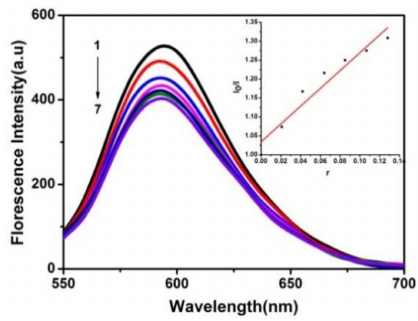
Figure 3. The effects of complex 1 on the fluorescence spectra of an EB-DNA system. [DNA] = 25 µ M, [EB] = 3 µ M, from 1 to 7 [complex]/[DNA] = 0, 0.0212, 0.0424, 0.0636, 0.0848, 0.106, 0.128, respectively; inset plot of I 0 /I versus r (r = [complex]/[DNA]). λ ex = 258 nm.